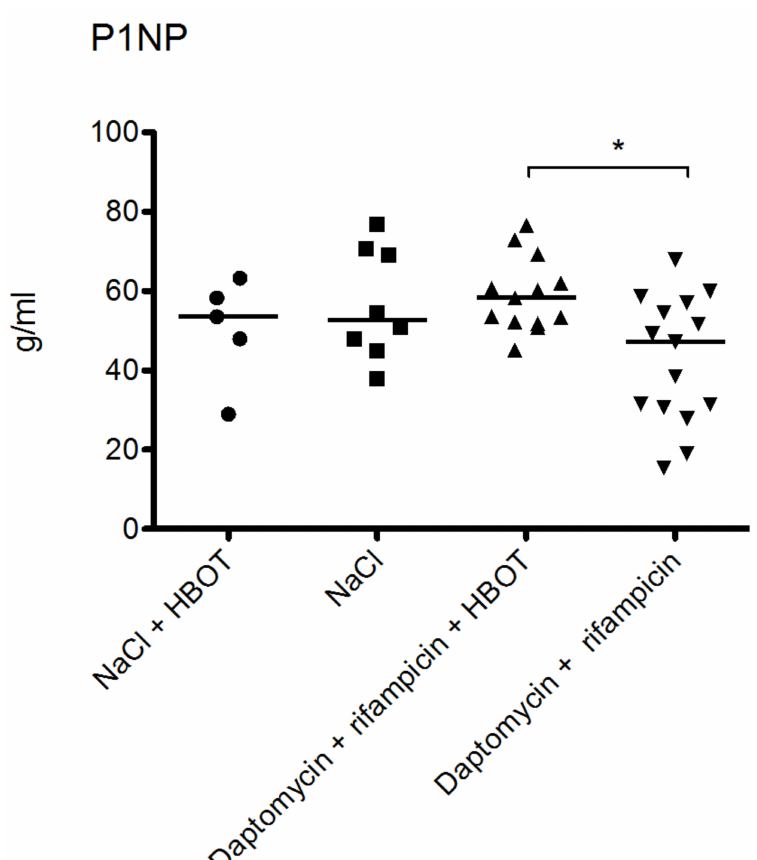
Figure 3. Procollagen type 1 amino-terminal propeptide (P1NP) levels were comparable in the two groups treated with NaCl. In the NaCl + HBOT group the median concentration was 53.53 g/mL (range: 28.98–63.24 g/mL), while the median concentration was 52.65 g/mL (range: 37.94–76.92 g/mL) in the NaCl group. There was no significant difference between these two groups ( p = 0.62 Mann Whitney’s test). HBOT resulted in slightly elevated P1NP levels in animals treated with daptomycin + rifampicin. Median P1NP concentration was 58.25 g/mL (range: 45.25–76.55 g/mL) for the daptomycin + rifampicin + HBOT group compared to 47.11 g/mL (range: 15.30–67.86 g/mL) in the daptomycin + rifampicin group. * marks significant statistical difference ( p = 0.0086, Mann Whitney’s